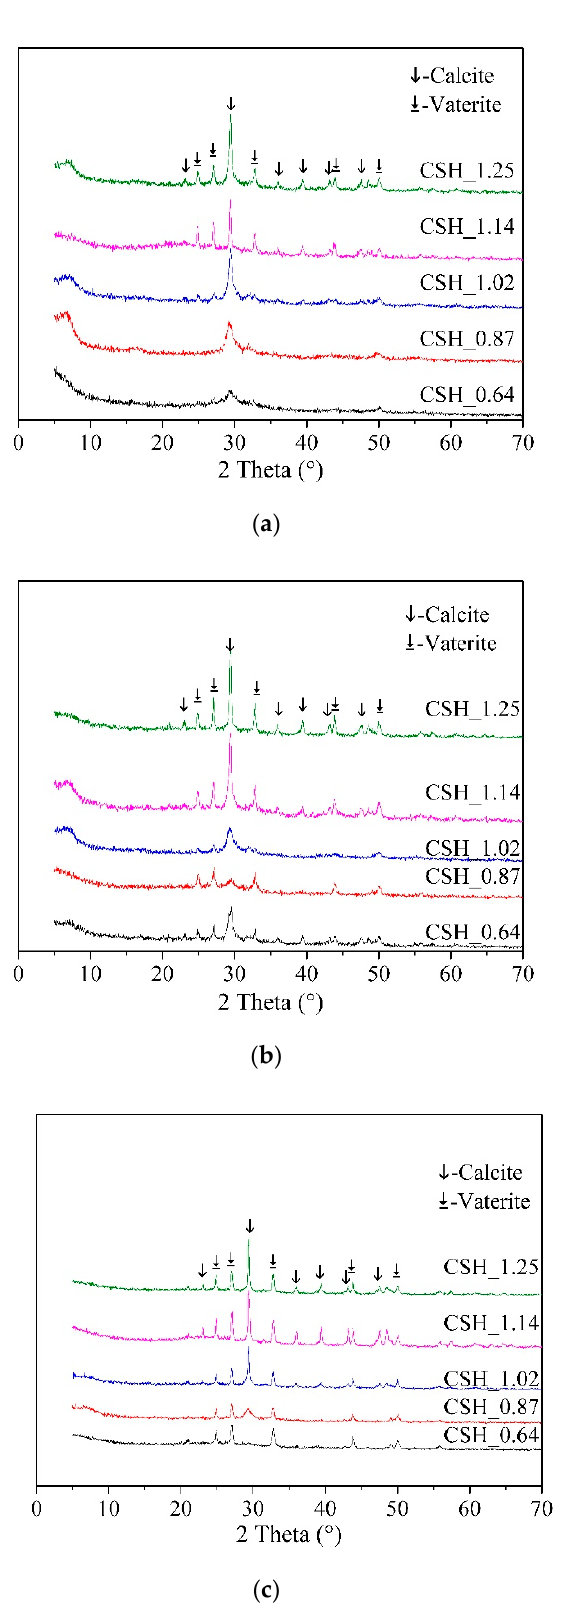
Figure 3. XRD patterns of C-S-H with different Ca/Si ratio after carbonation for ( a ) 1 day, ( b ) 7 days and ( c ) 28 days.